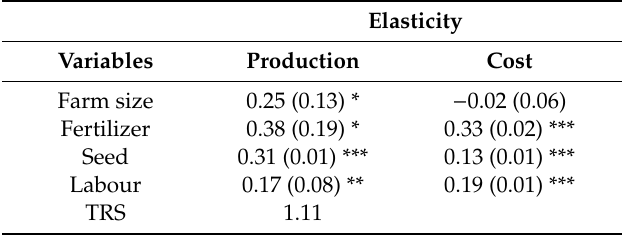
Table 6. Estimates of production and cost elasticities and return to scale of